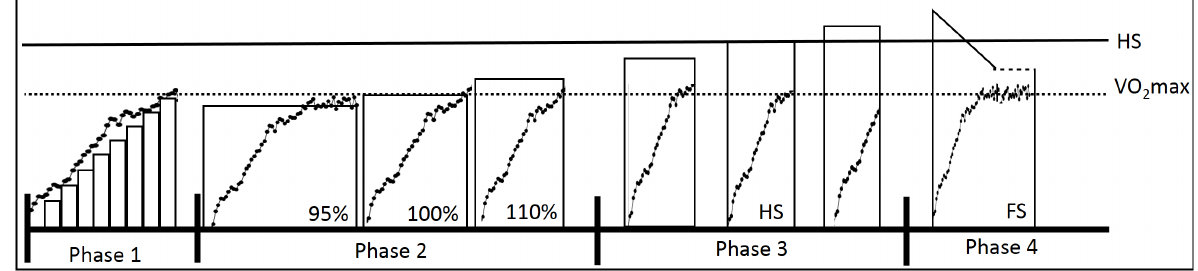
Figure 1. Schematic representation of the protocol timing during the four phases. The superimposed data points are merely illustrative data representing V˙O 2 response during tests. V˙O 2 max, maximal oxygen uptake (dashed line); HS, highest speed (solid line); FS, fast-start pacing strategy. See ‘‘Methods’’ for more details on phases one, two, three and four.